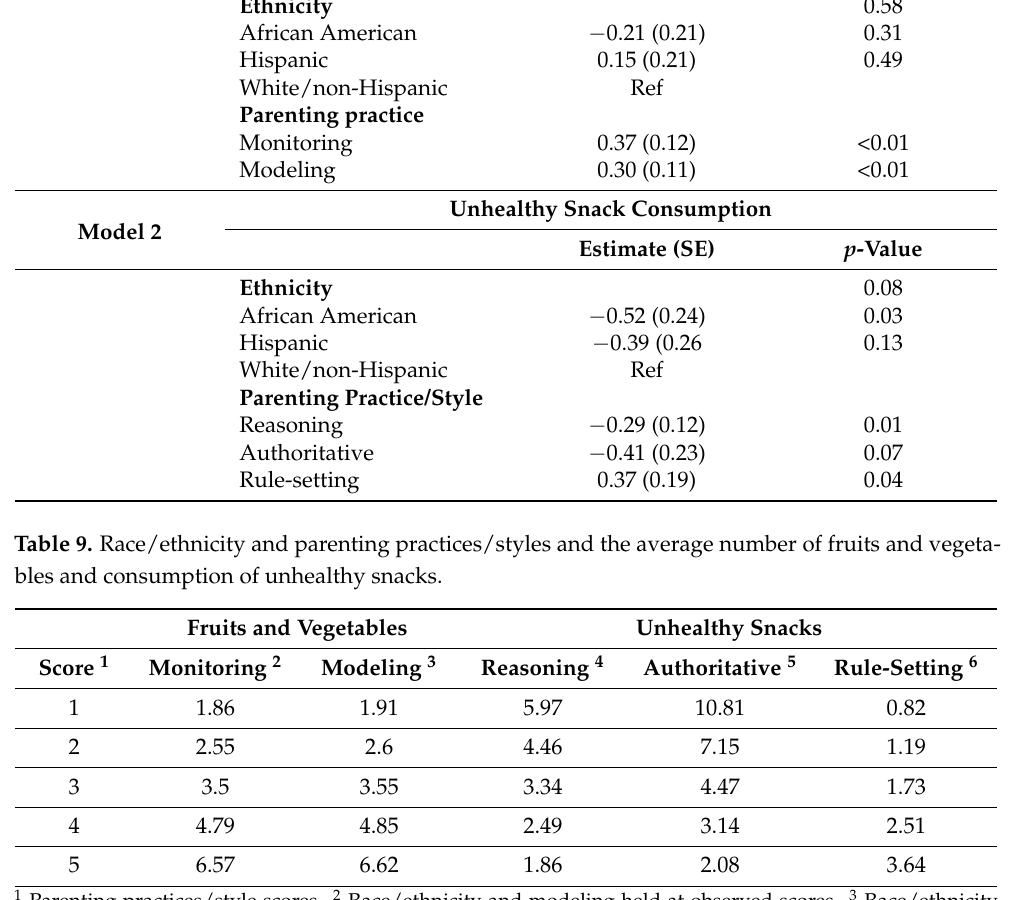
scores. 5 Race/ethnicity, reasoning, and rule-setting held at observed scores. 6 Race/ethnicity, reasoning, and authoritative held at the observed